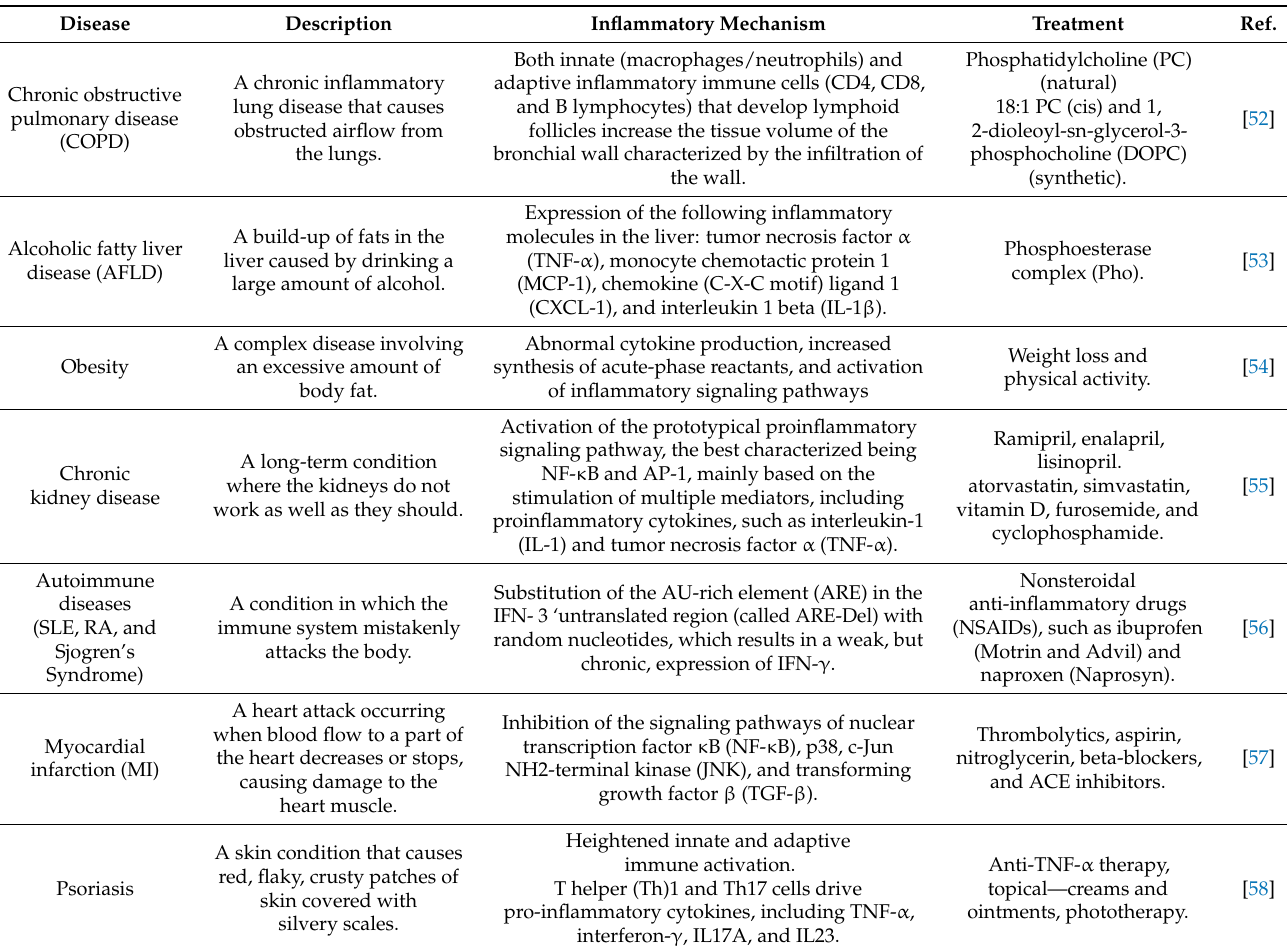
Table 1. Examples of chronic diseases related to